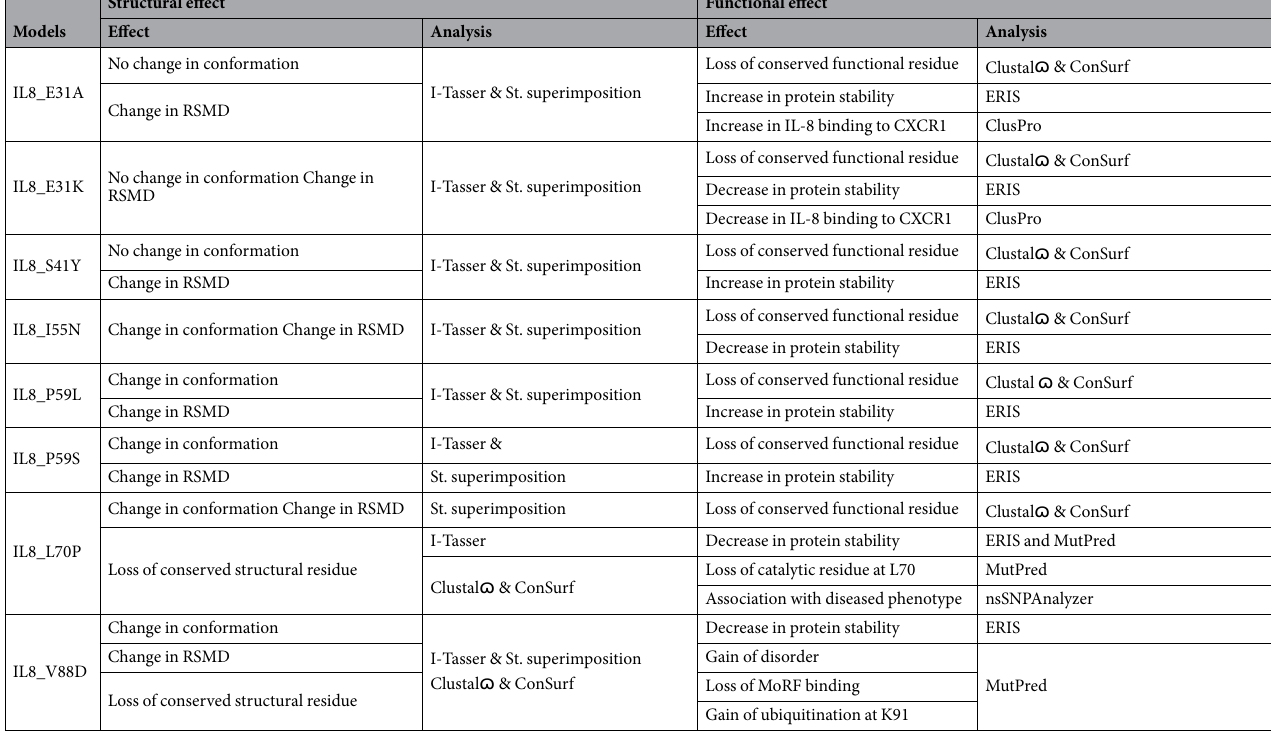
Table 8. The summary of possible structural and functional consequences in IL-8 protein as a result of nsSNPs in IL8